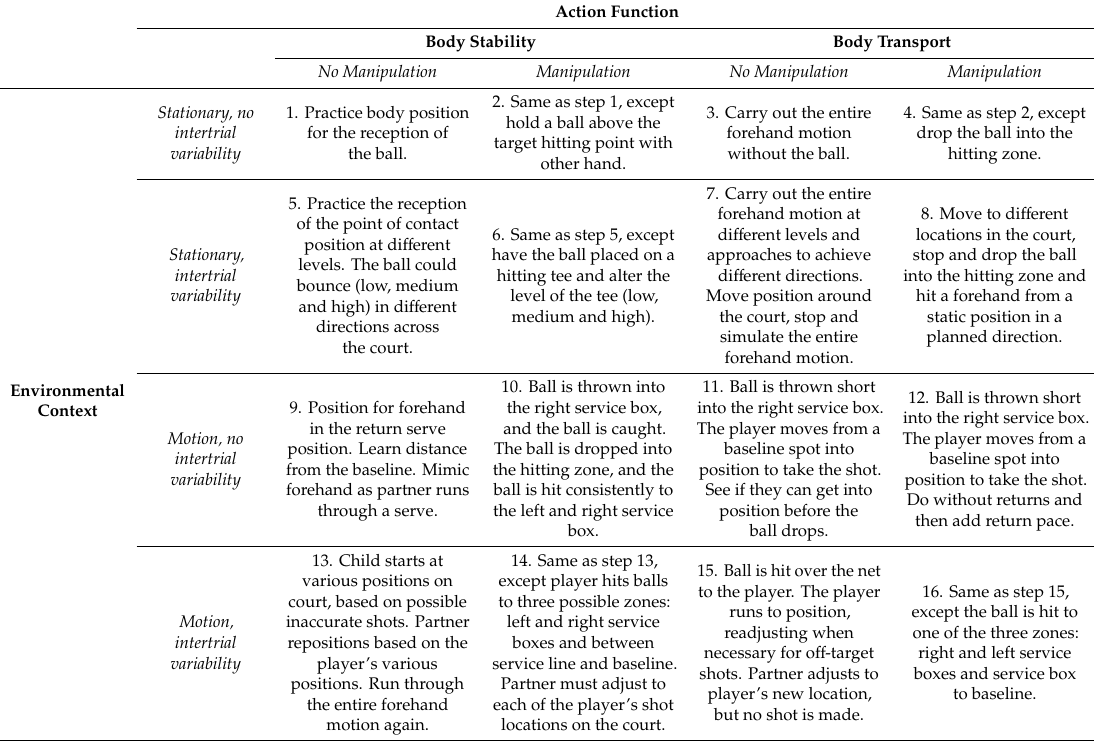
Table 1. Example of Gentile’s taxonomy for forehand